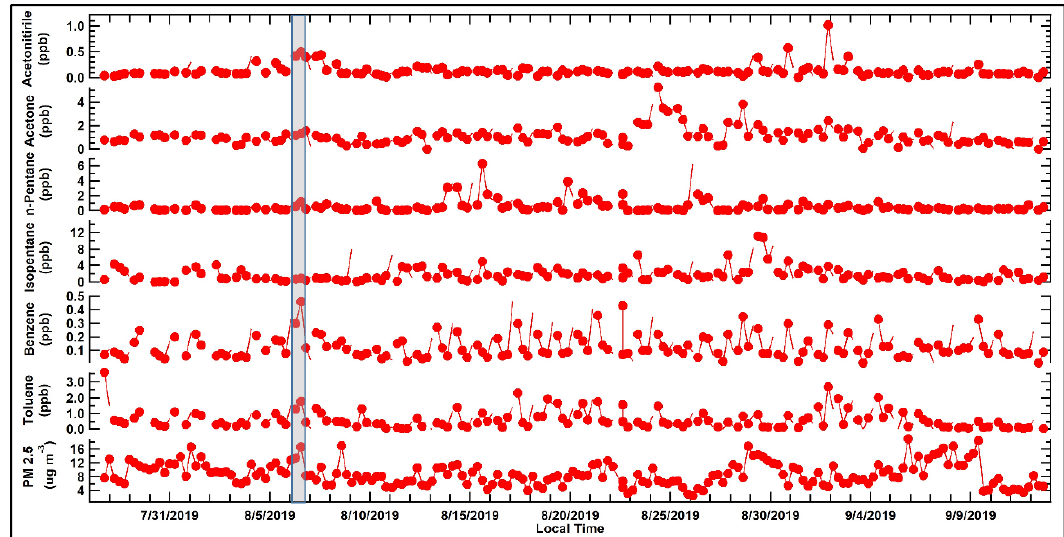
Figure 5. Time series of 6-hour averaged mixing ratios of VOCs and PM 2.5 measured at Boise, Idaho. Shaded period shows the influence of forest fire smoke. Table 2. Comparison of average mixing ratio (ppb) of VOCs measured at Boise and Spokane with other similar sites in the U.S.